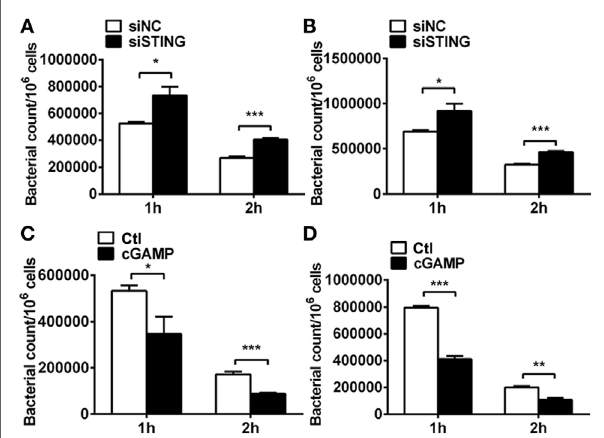
FigUre 7 | Stimulator of interferon genes (STING) regulated bacterial elimination in vitro. (a,B) Bacterial plate count was used to measure intracellular bacterial killing in murine macrophage-like RAW264.7 cells (a) and bone marrow-derived macrophages (B) with siRNA for mouse STING (siSTING) versus siNC treatment. (c,D) Bacterial plate count was used to measure intracellular bacterial killing in murine macrophage-like RAW264.7 cells (c) and bone marrow-derived macrophages (D) with 2 ′ ,3 ′ -cGAMP (cGAMP) versus control treatment. Data are shown as mean ± SEM of three independent experiments. * P < 0.05; ** P < 0.01; and *** P <